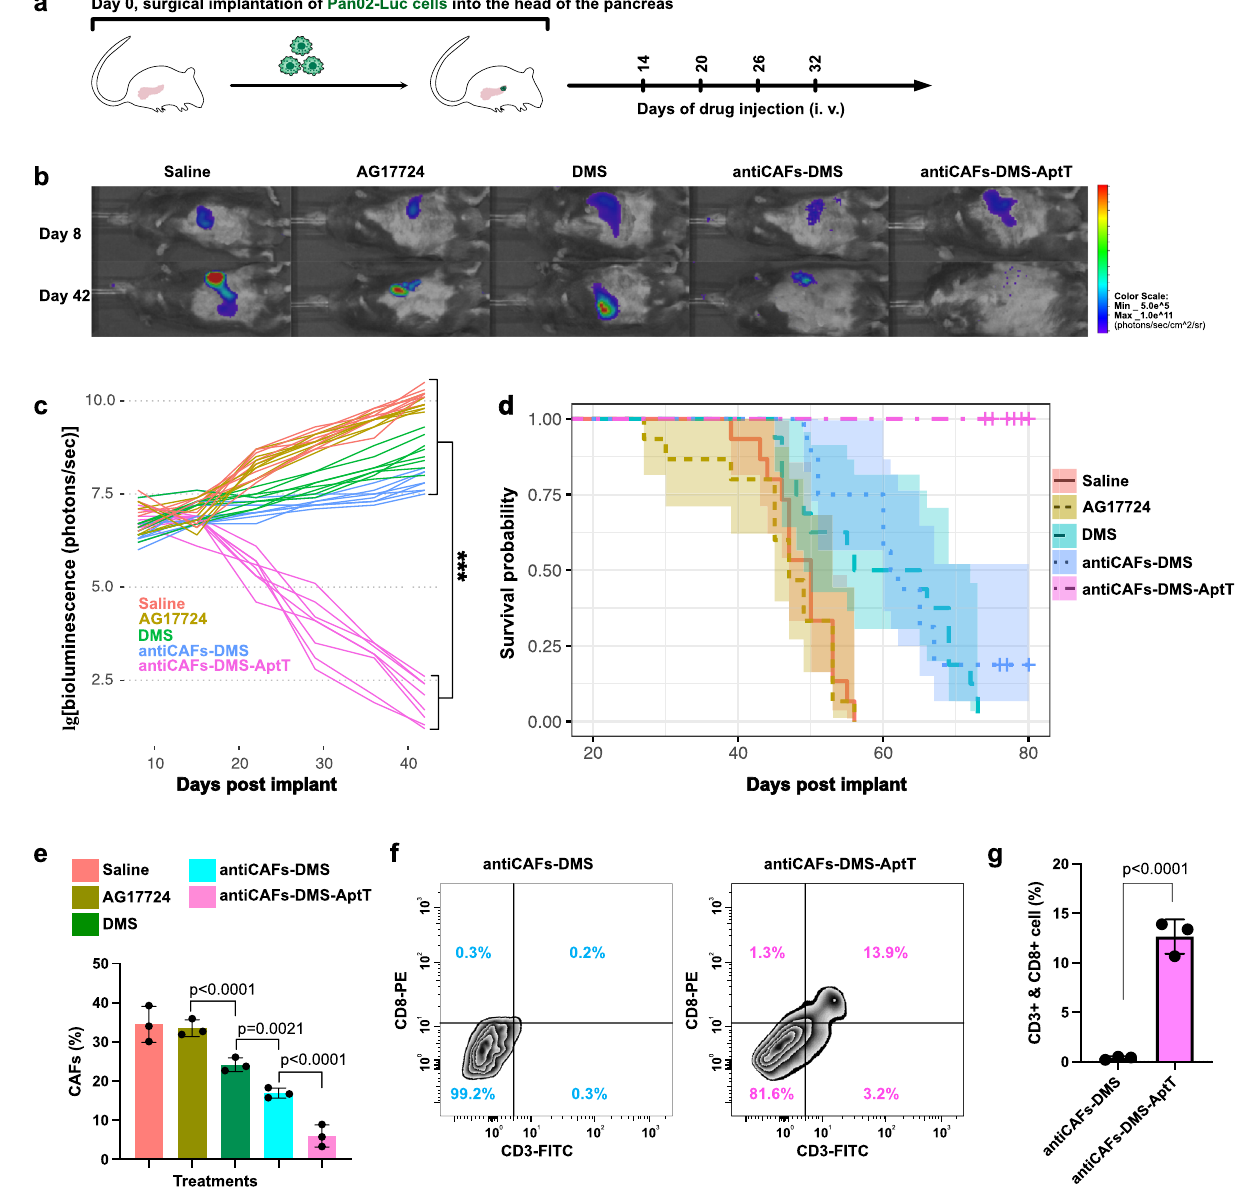
Fig. 7 | Treatment effects of antiCAFs-DMS-AptT on orthotopic pancreatic cancermodel.a Treatmentscheduleofmicebearingorthotopicpancreaticcancer. b Representative bioluminescent images of mice treated with different formula- tions atday 8 and day 42 post cancer establishment (six mice per group). c Tumor development of each mouse, quanti fi ed by bioluminescence signal (six mice per group). Two-way ANOVA. d Kaplan – Meier survival curves of mice (six mice